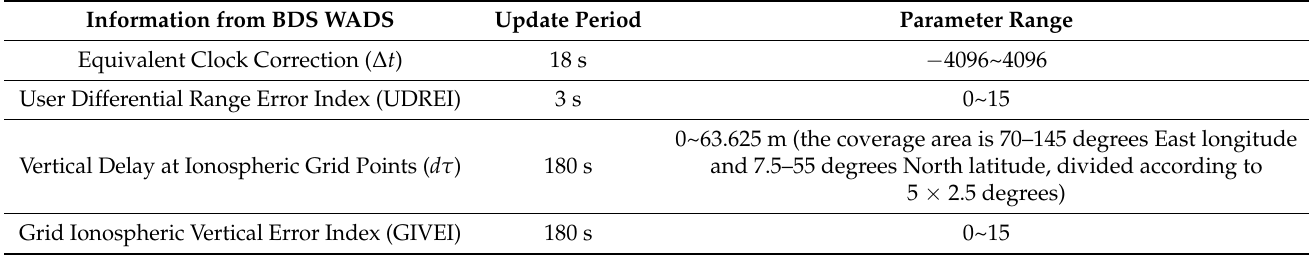
Table 1. BDS WADS (D2) messages on B1I/B3I frequency.